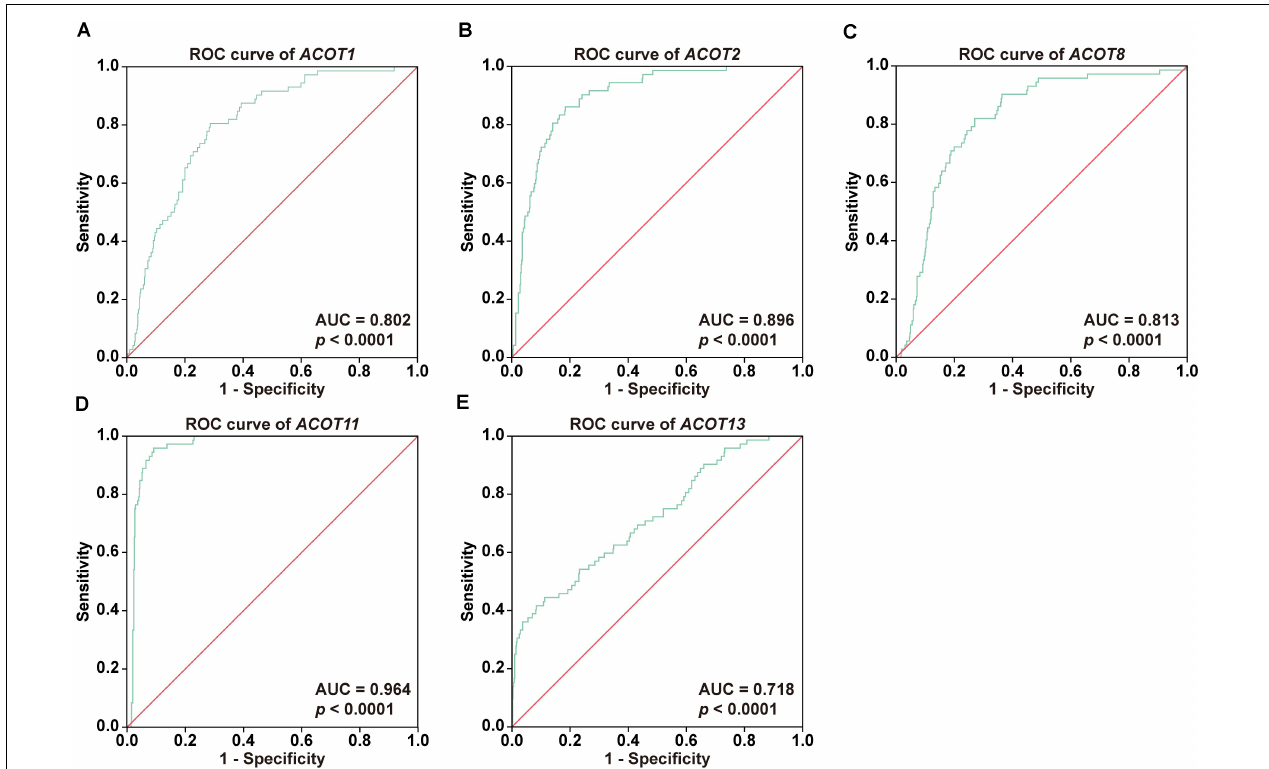
FIGURE 2 | Diagnostic values of different ACOTs in ccRCC were shown by ROC curves. The transcriptional expression data of ACOT1/2/8/11/13 in 526 ccRCC and 72 normal kidney samples from TCGA KIRC dataset were used in ROC analysis. ROC curves and respective AUC scores are shown in (A–E) . p- Value < 0.05 was regarded as statistically